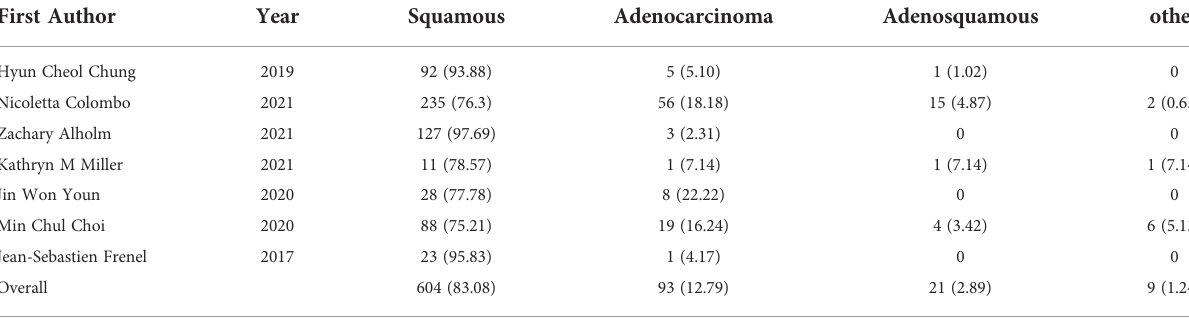
TABLE 2 Cont. Proportion of case types included in the literature N (%).